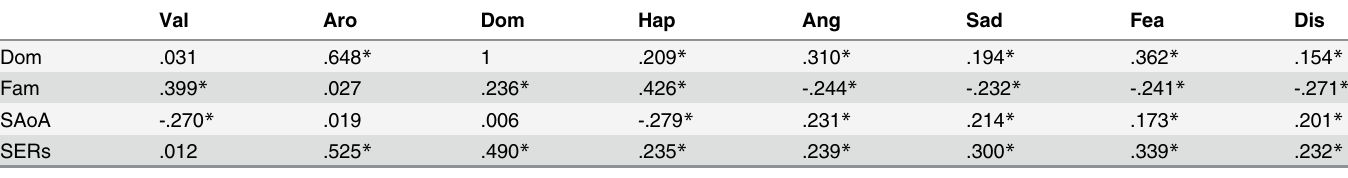
Table 2. Correlations between dominance (Dom), Familiarity (Fam), subjective age of acquisition (SAoA) and sensory experience ratings (SERs) and the affective variables of valence (Val), arousal (Aro) and the discrete emotions (happiness, Hap; anger, Ang; sadness, Sad; fear, Fea; disgust,